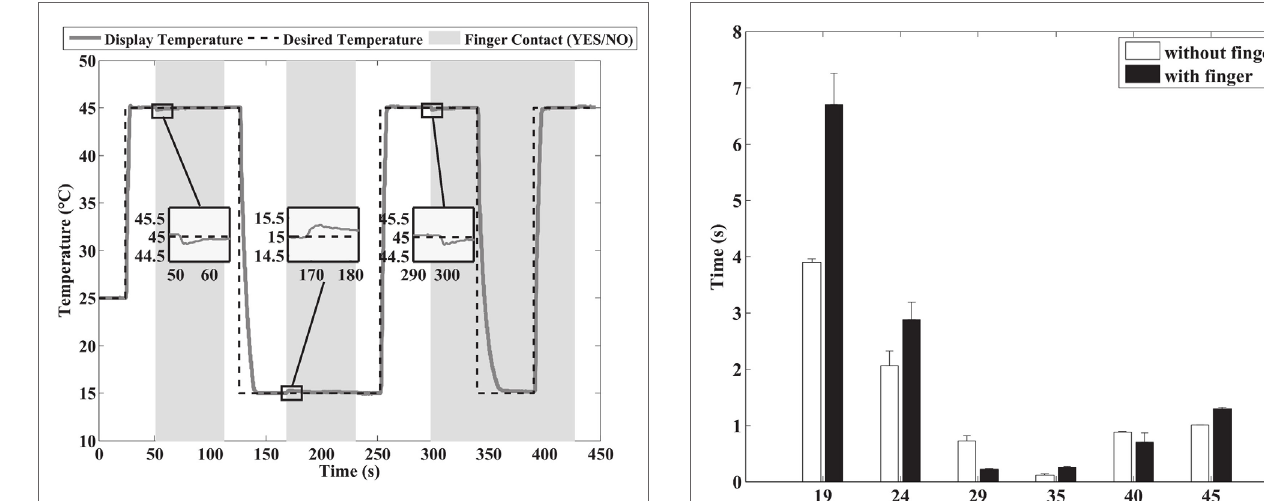
FigUre 2 | single Peltier behavior . The behavior of a single Peltier unit with and without finger contact for temperature steps from 15 to 45°C (and vice versa) is illustrated. Temperature stability is within ± 0.15°C of the desired temperature and response to the external perturbation is within ± 0.5°C.